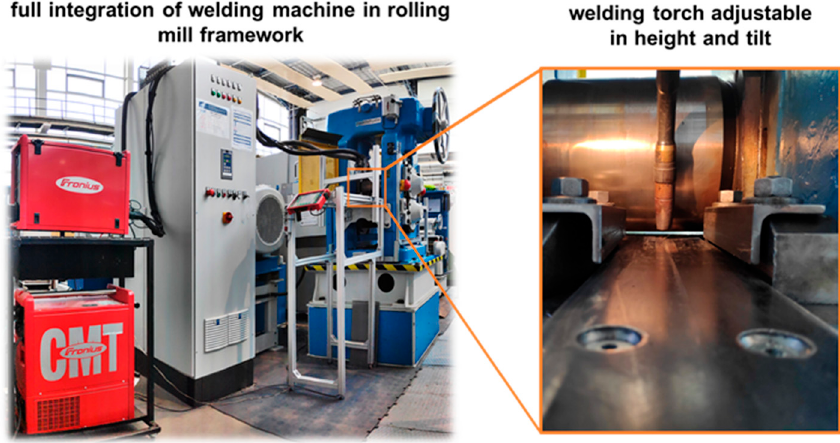
Figure 5. Experimental setup for the WeldForming process.